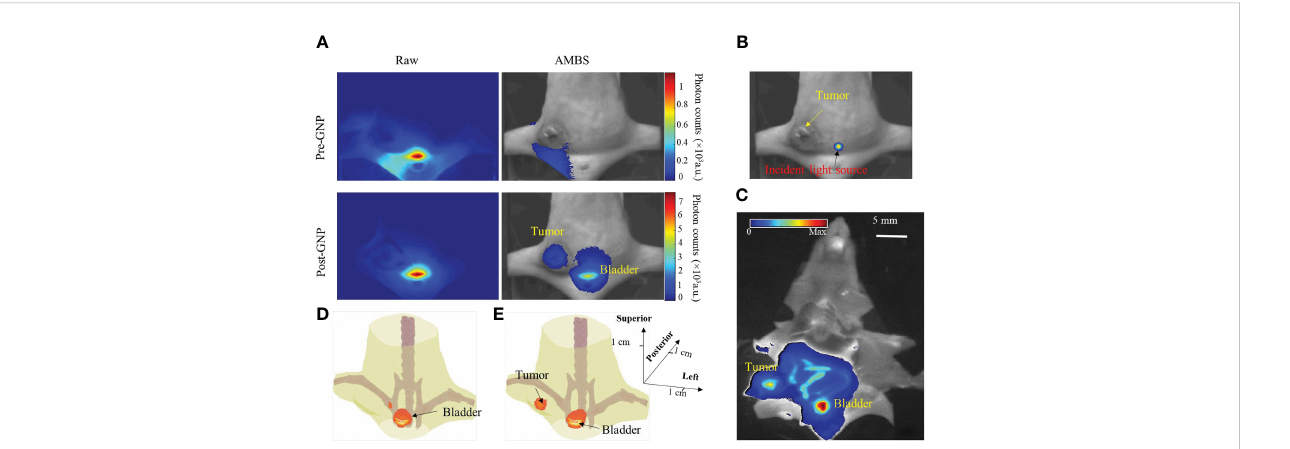
FIGURE 5 (A) Raw and AMBS-corrected fl uorescence images before and after intratumoral injection of fl uorescent GNRs. AMBS images were normalized to the maximum of the corresponding raw images. (B) Trans-illuminating light source is overlapped onto white-light image to indicate the excitation location. (C) Organ fl uorescence imaging of the dissected animal, using Kodak In Vivo Multispectral Imaging system. (D, E) FMT reconstruction based on the raw and AMBS-corrected fl uorescence images,